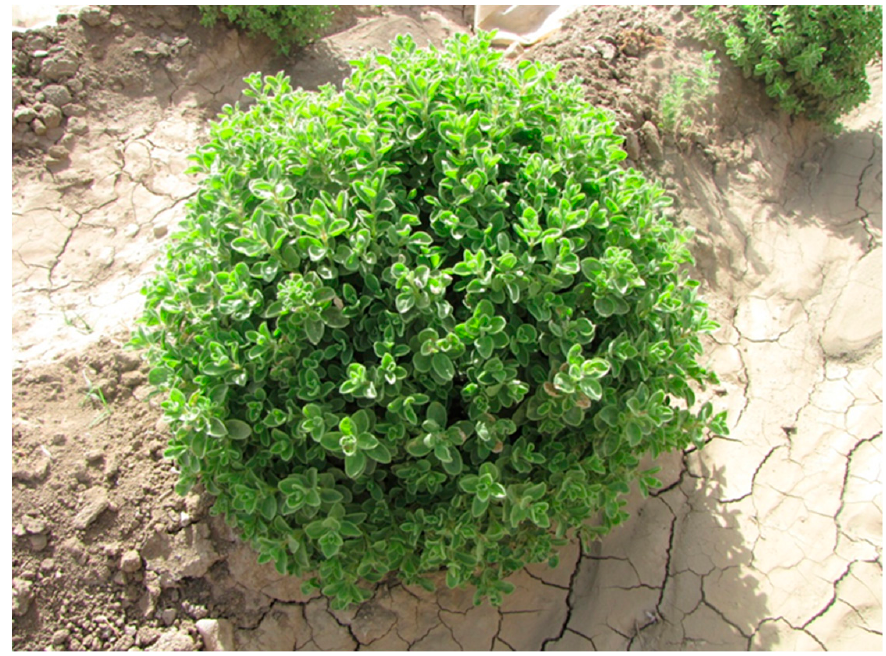
Figure 3. A cultivated Satureja khuzistanica Jamzad plant in southwestern Iran.